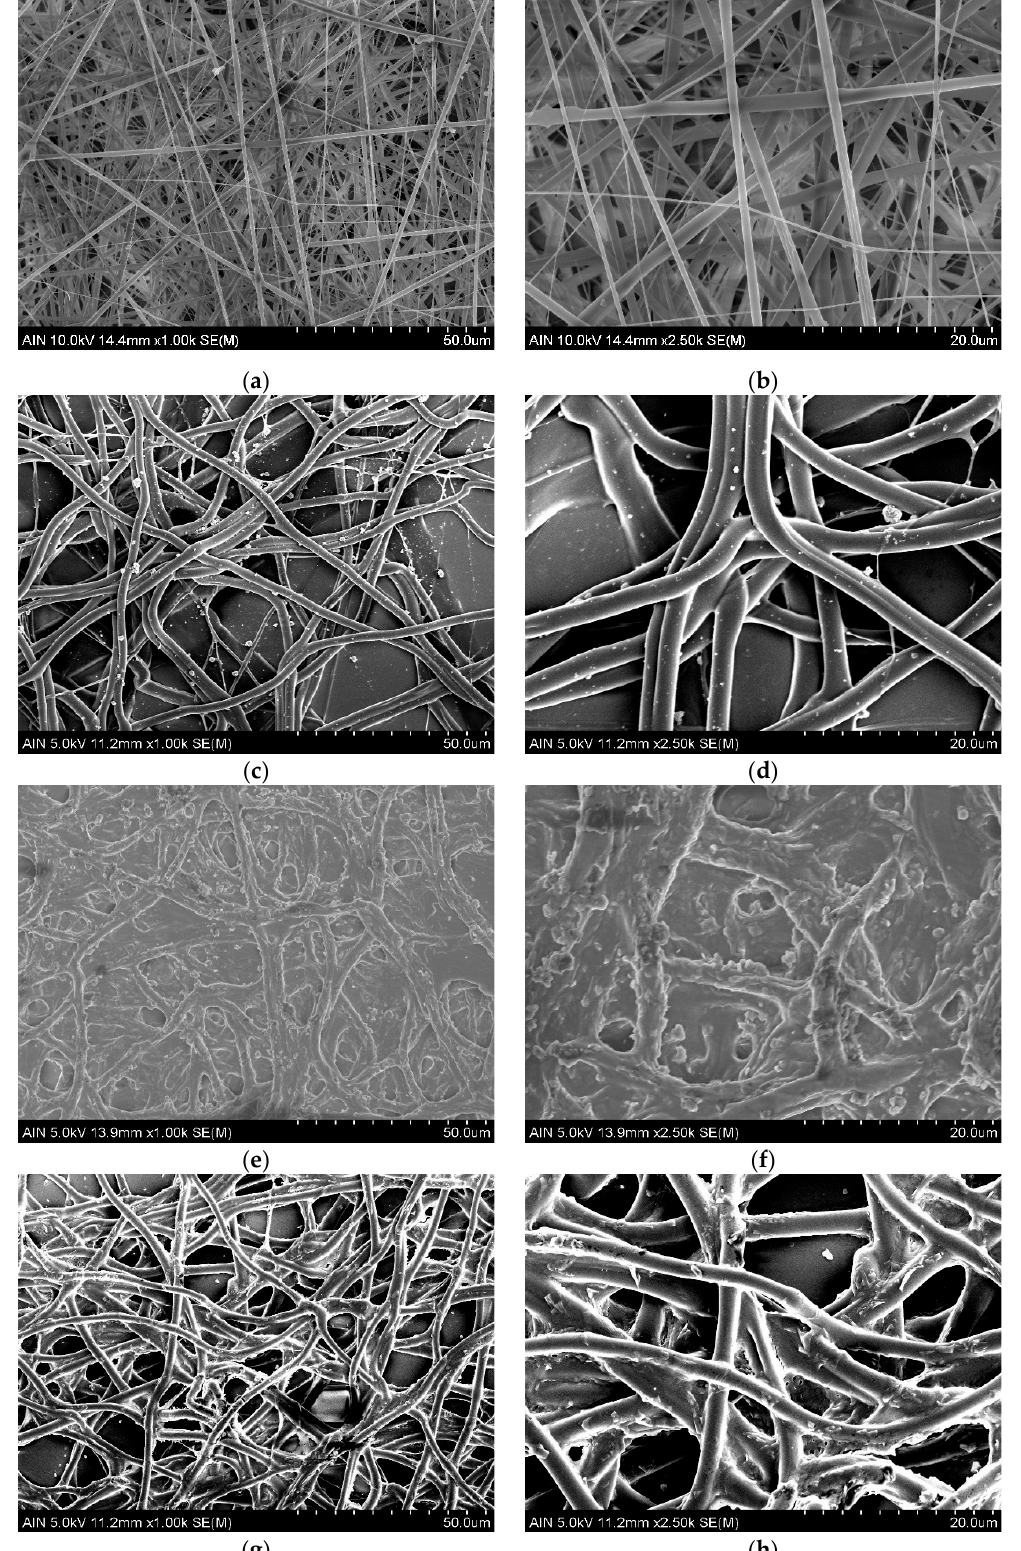
Figure 2. SEM images of the samples in two different magnifications: ( a ) Fiber morphology of Ref sample with × 1000 magnification; ( b ) Fiber morphology of Ref sample with × 2500 magnification; ( c ) Fiber and TiO 2 nanoparticles morphology of ESpr sample with × 1000 magnification; ( d ) Fiber and TiO 2 nanoparticles morphology of ESpr sample with × 2500 magnification; ( e ) Fiber and TiO